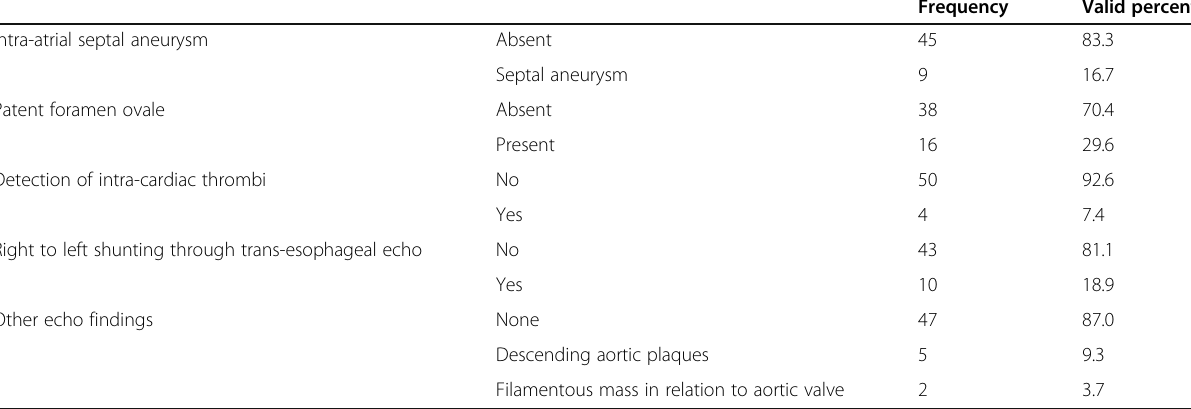
Table 1 Abnormal findings in transesophageal echo (sources of cardioembolism) Intra-atrial septal